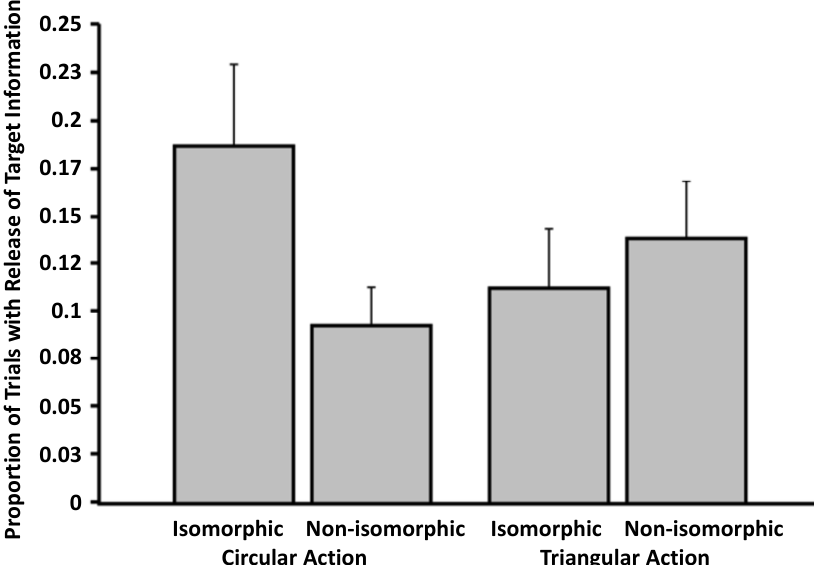
Figure 8. Proportion of trials involving release from masking as a function of action and isomorphism (Experiment 3). The data are culled from a content analysis of participants’ descriptions about targets. Error bars signify